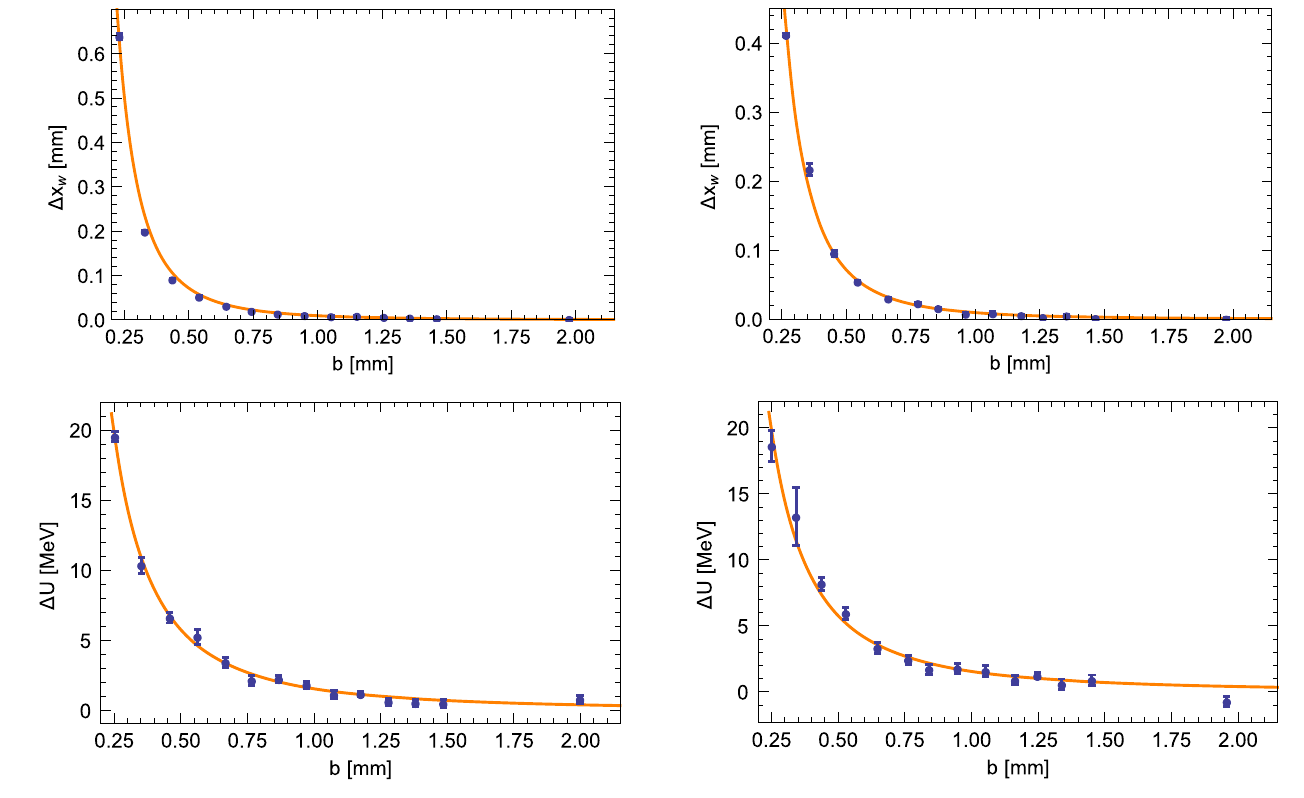
FIG. 5. Single north jaw measurements of transverse (top) and longitudinal (bottom) wakefield kicks. The symbols give the data points, with their b values shifted by − 161 μ m (top) and − 138 μ m (bottom); the curves give the analytical theory.